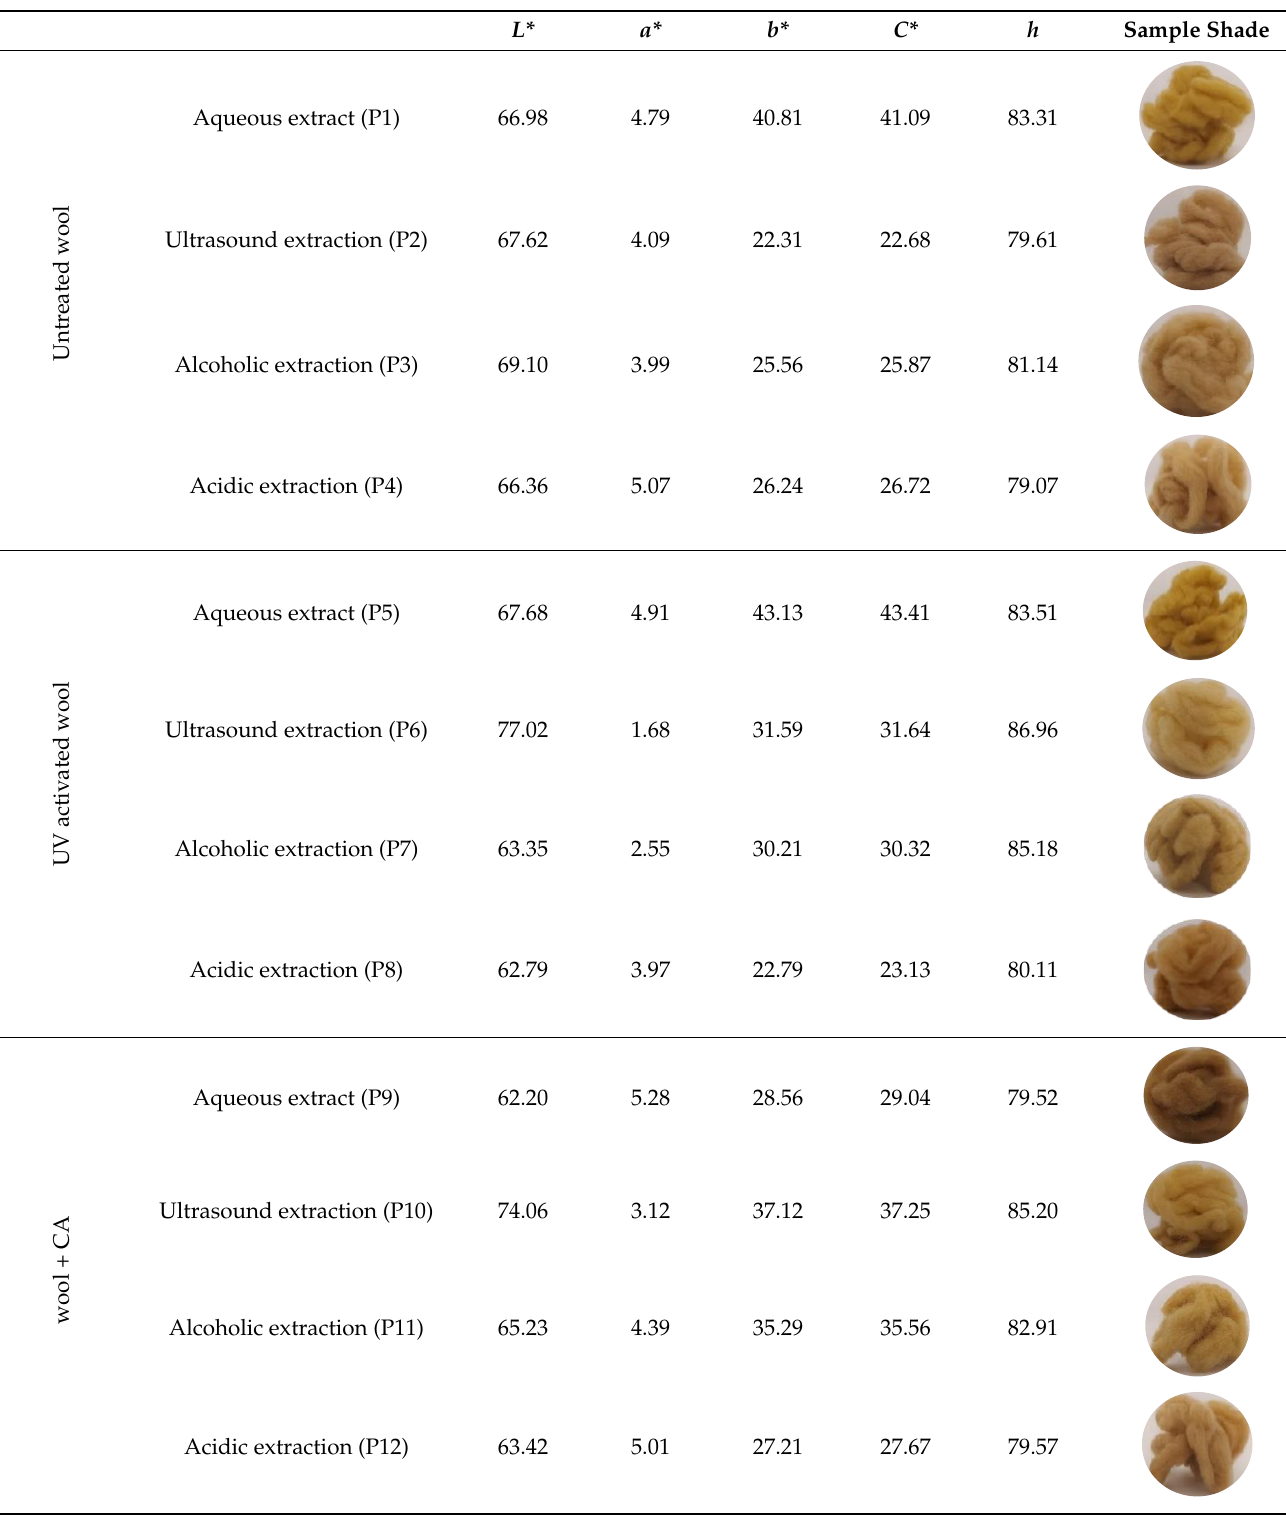
lower dye absorption in the fiber. The CIE ( L* — lightness of the color; a* — red/green balance of color; b* — yellow/blue balance of color; C* — chromaticity; h — hue angles) color coordinates [21] are listed in Ta- ble 3. The application of celandine extracts on wool fibers produced yellow shades, pos- sessing hue angles ranging between 79.07 and 83.31 for untreated samples, between 79.52 and 85.20 for wool samples pretreated with citric acid, and between 80.11 and 86.96 for UV-activated wool samples. The decrease in lightness was attributed to more dye being absorbed into the wool fibers, producing a darker shade. Dyeing with ultrasound extract is the lightest. Table 3. CIE- L*a*b* values, and shades of dyed wool samples. L* a* b* C* h Sample Shade